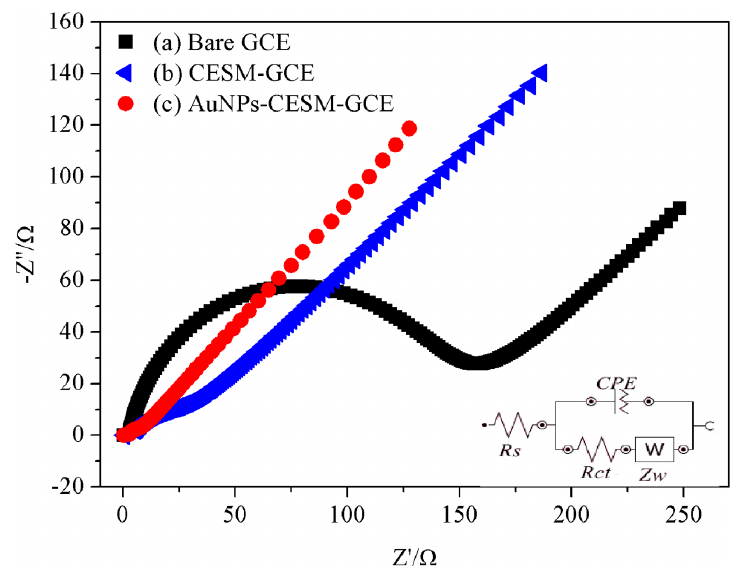
Fig 5. Electrochemical impedance spectroscopy of modified electrodes. Bare GCE (a), CESM-GCE (b), AuNPs – CESM-GCE (c), in 0.1 M pH 7.0 PBS containing 1 mM [Fe(CN) 6 ] 3-/4- (inset: Randle ’ s equivalent